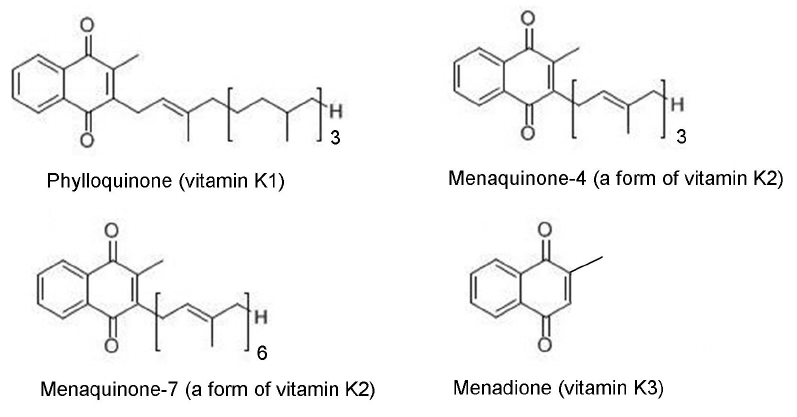
Figure 1. Forms of vitamin K.